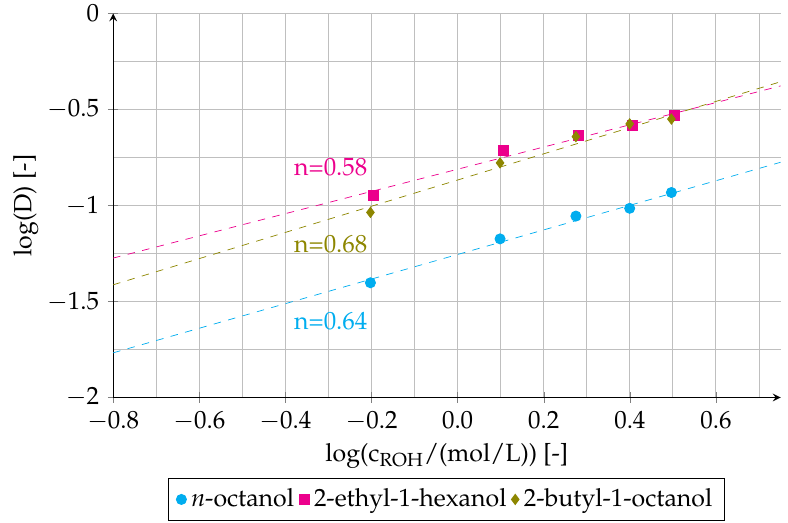
Figure 5. Determination of the stoichiometry of the extraction species by slope